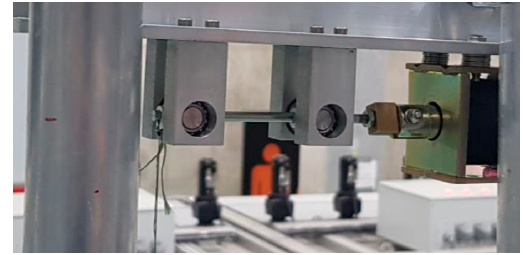
Figure 11. Release system consisting of a pushrod and an electrical actuator.